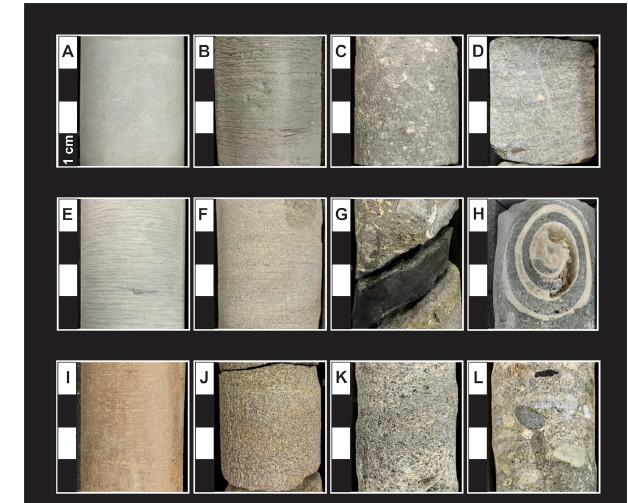
Figure 6. Core sections showing lithologies identified in this study: (A) marl (SER-01, 30.68–30.74m); (B) shale (SER-01,